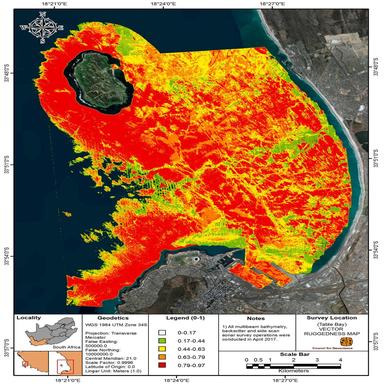
Vector Ruggedness Measure (VRM) map of Table Bay. VRM measures roughness as the dispersion of vesctors othognonal to the surface within a specific nerighbourhood. This value ranges from 0 to 1, with 1 being the most rugged, and 0 the least. The map shows the areas dominated by rock outcrops have a higher ruggedness, as expected.